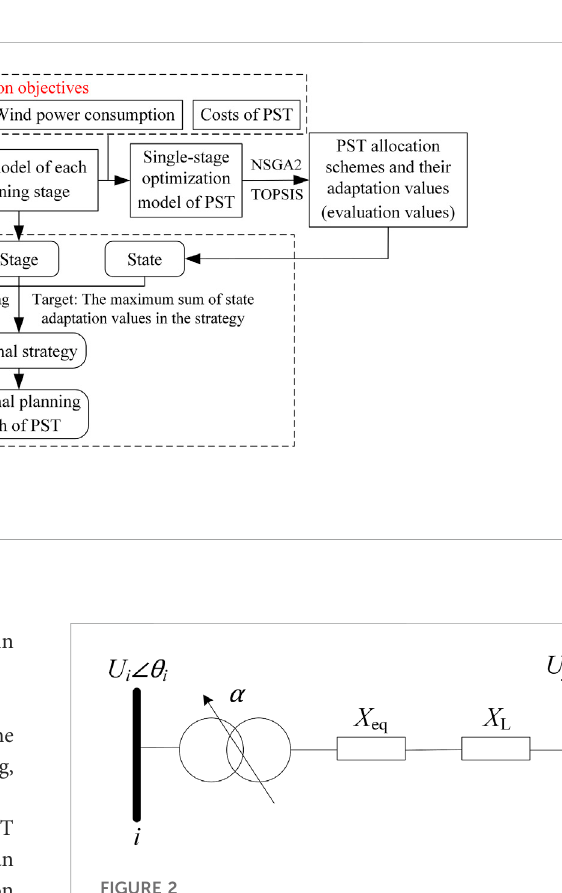
FIGURE 2 The equivalent circuit of the branch with